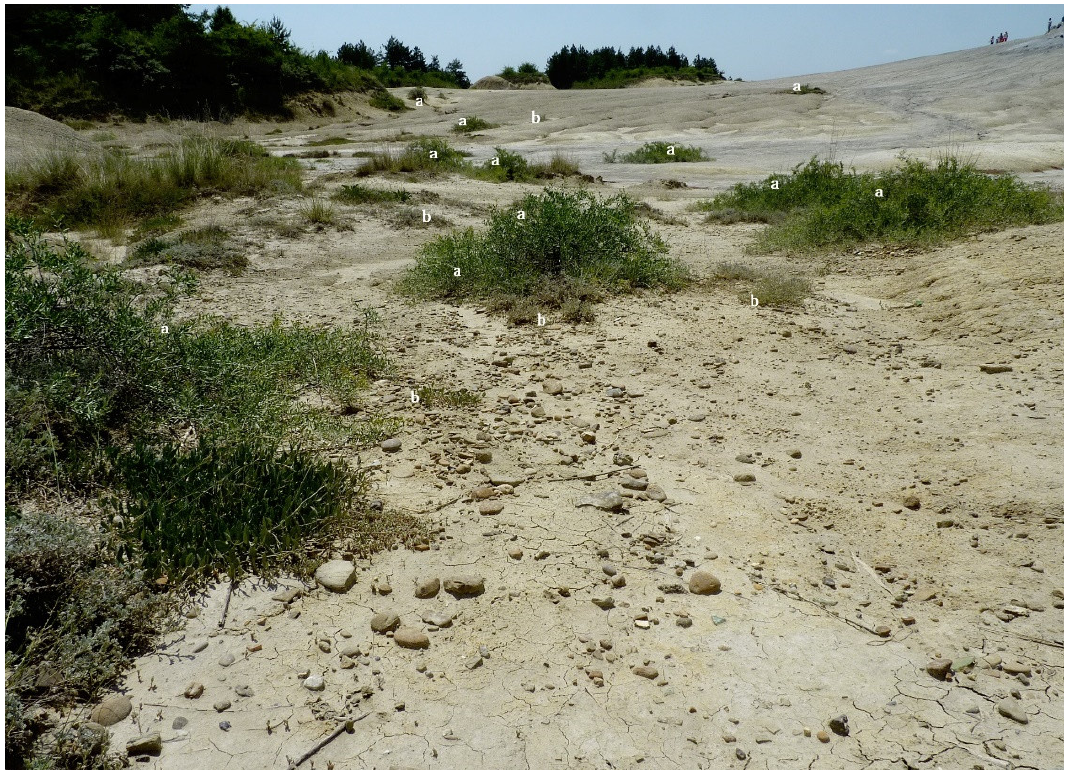
Figure 2. N. schoberi habitat—almost bare soil with a few nitre-bush (a) and A. verrucifera (b) individuals.